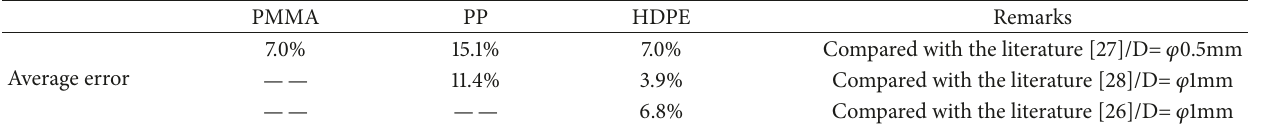
Table 3: Average error of SVAE